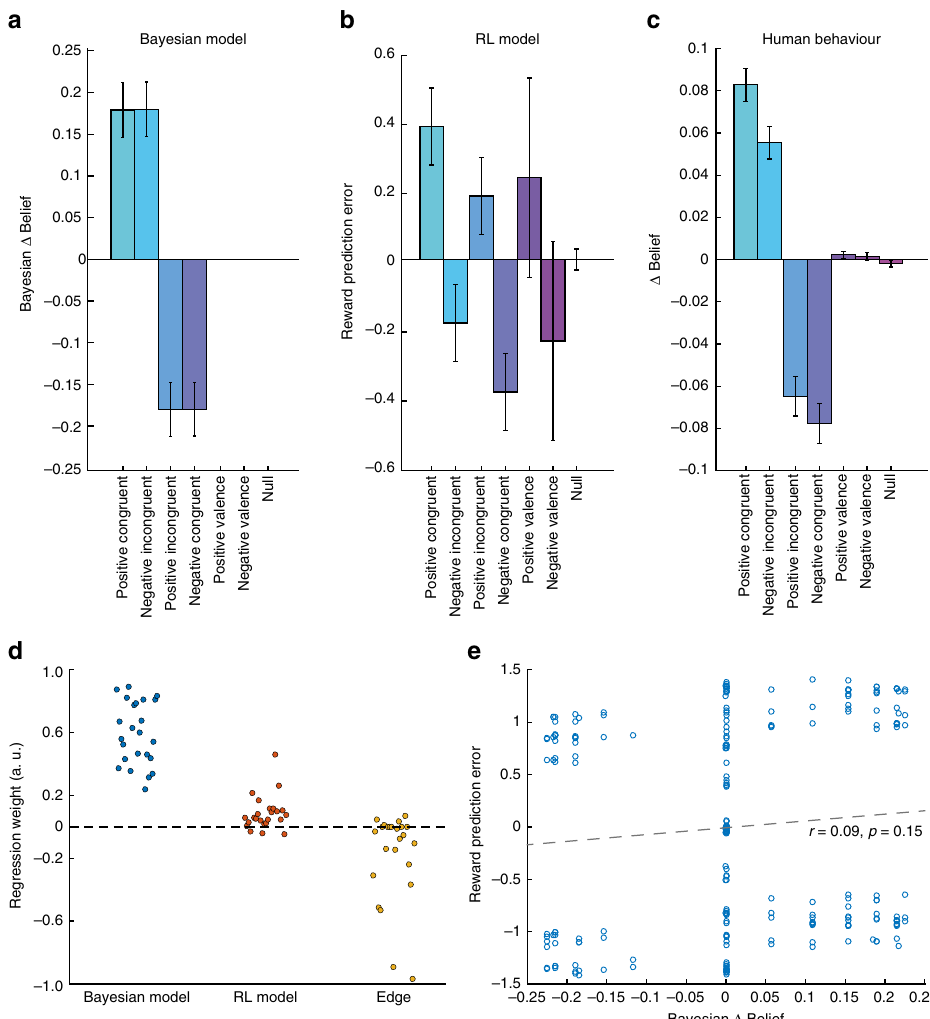
Fig. 2 Modelled and observed behaviour in the task. The Bayesian learner a updates equally on congruent and incongruent informative events, and does not update on non-informative events (rightmost three entries). b Reward prediction errors (RPE) that update the model-free reinforcement-learner (RL) do not differentiate informative and non-informative events, and instead mainly re fl ect the valence of the outcome. c Human participants update their beliefs positively on positive congruent and negative incongruent events and vice versa for negative updating. They also do not update their belief estimates signi fi cantly on non-informative valence events, but instead show characteristics of biased updating by model-free learning: they update beliefs signi fi cantly less on incongruent pay-outs (see Supplementary Fig. 1 for a more in-depth analysis of the congruency effect). d Results of within-participant regression analyses comparing the in fl uence of both learning models. All participants in the study were described by the update predicted by the Bayesian model, yet additionally a signi fi cant positive covariation between participants ’ belief estimate updates and the model-free RPE was seen. Factor edge controlled for the tendency of some participants to decrease updating at extreme values of possible beliefs (i.e., zero or one, t 23 = − 3.0, p = 0.0063). e Correlation of Bayesian belief update and normalised RPE across the task in one random example participant illustrating that both regressors were de-correlated. Predictions of both models are based on 5000 random trial sequences. Error-bars represent SD in plots a and b , and SE in